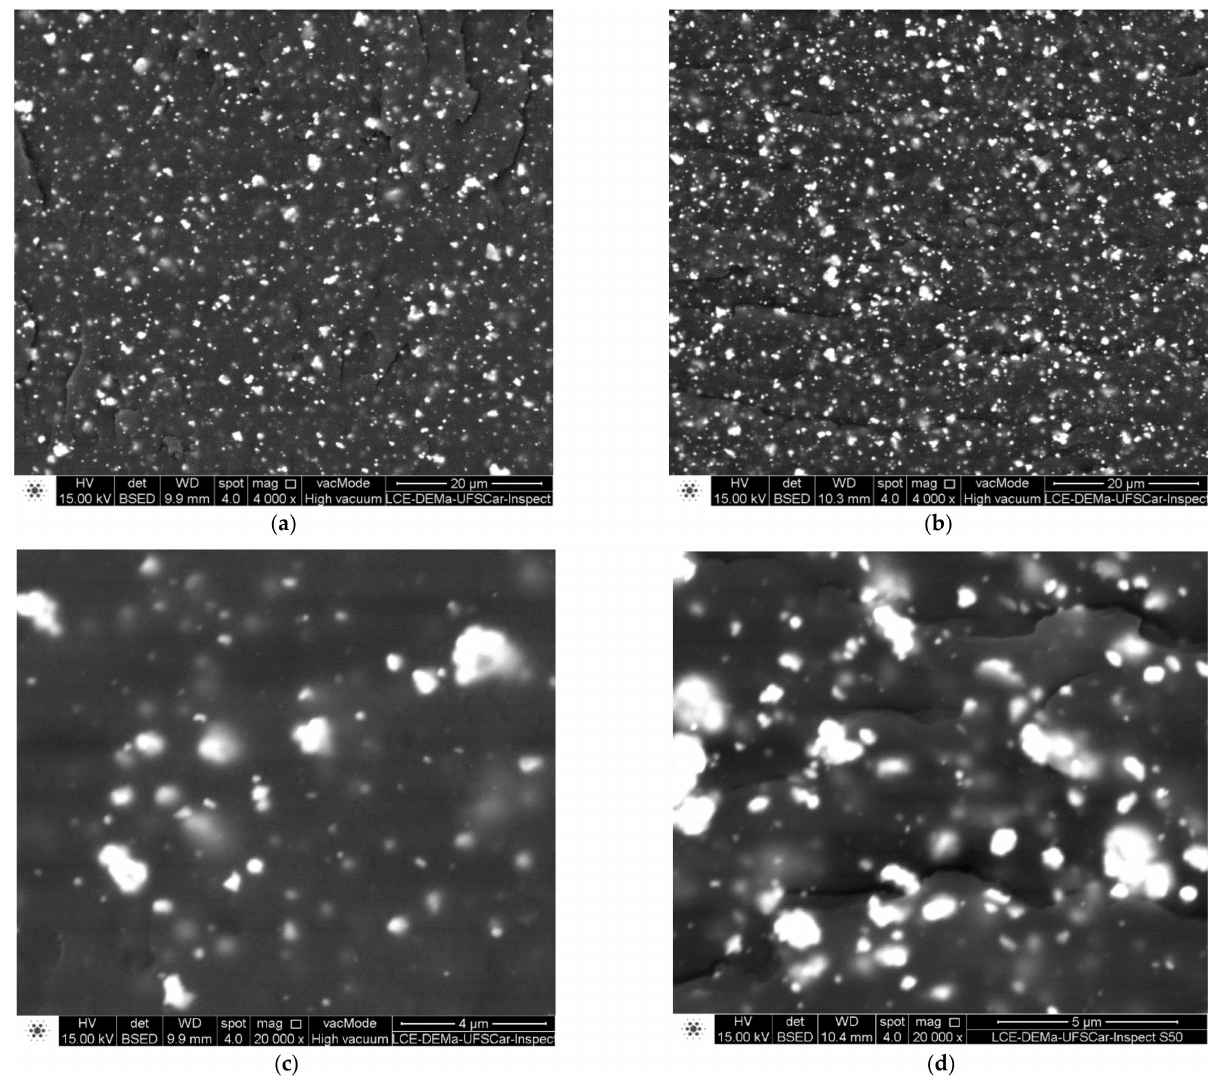
Figure 6. SEM images of fractured surfaces of extruded composites: ( a ) and ( c ) SNaPZT3 e ; ( b ) and ( d ) SNaPZT5 e (superscript “e” corresponds to extruded